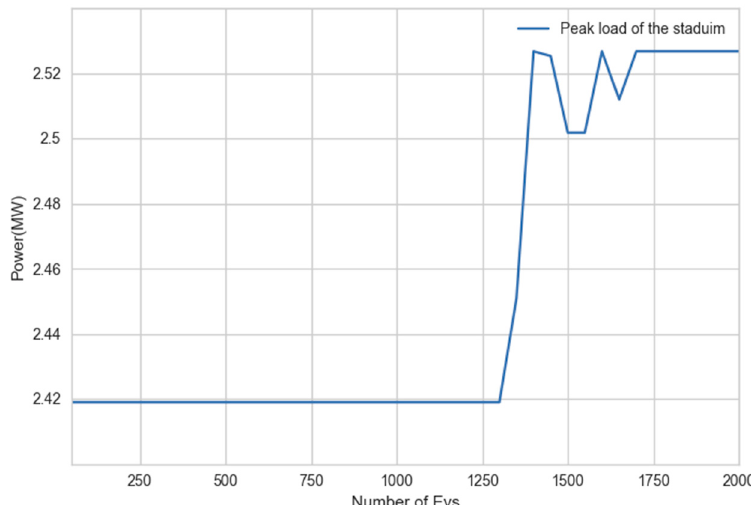
Figure 13. The maximum peak load of the stadium in Scenario 3 for different numbers of EVs. Note that the storage system is steered to best compensate for the load profile occurring in the entire feeder in this case.